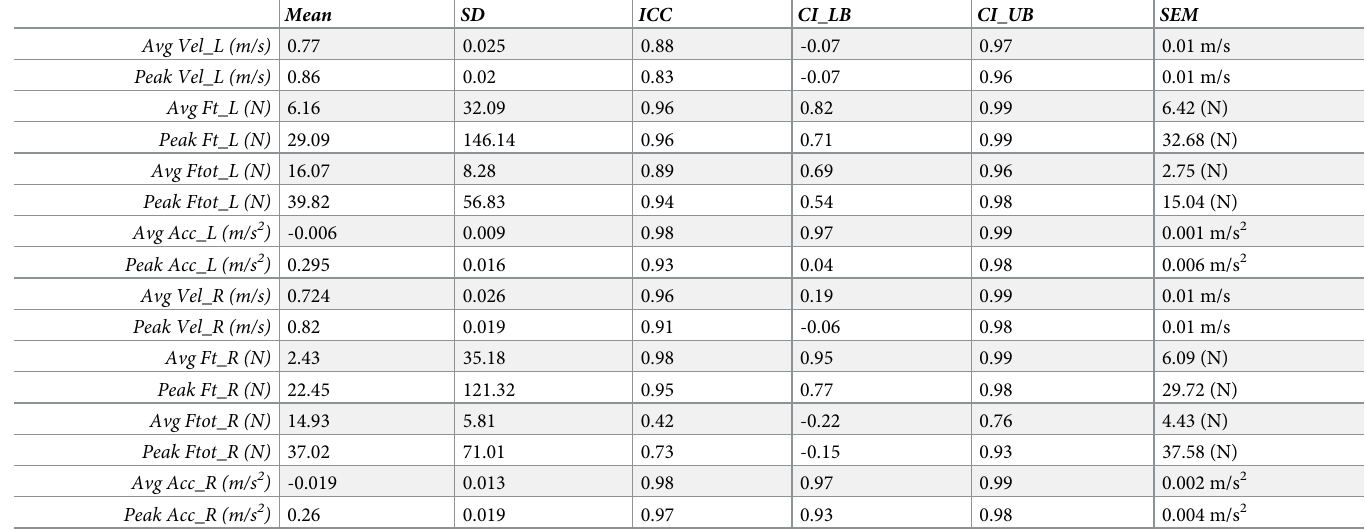
Table 2. ICC, lower and upper band of confidence interval, as well as standard error of measurement (SEM) for the sixteen variables of data series parameters: Average and peak values of velocity, acceleration, tangential and total force, each for the left and right. Mean SD